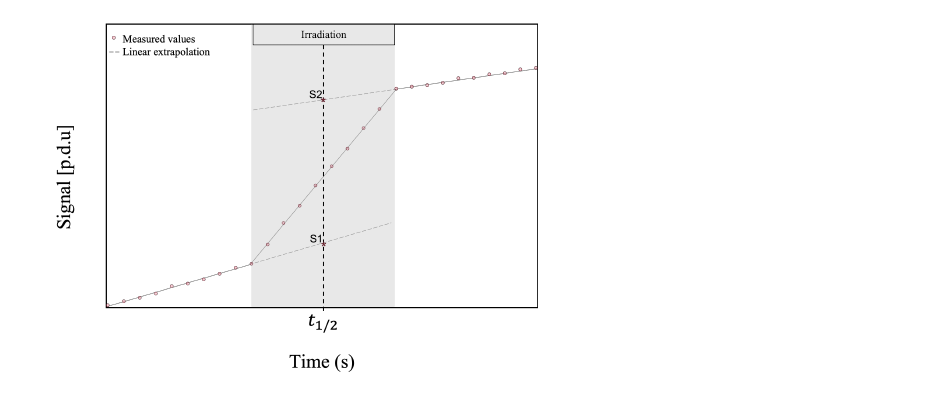
Figure 1. Example of pre-irradiation and post-irradiation temperature drift correction technique, for which two linear extrapolations are created, one with the pre-irradiation signal and one with the post-irradiation signal and evaluated (corresponding to S1 and S2 on the figure) at mid-irradiation time ( t 1/2